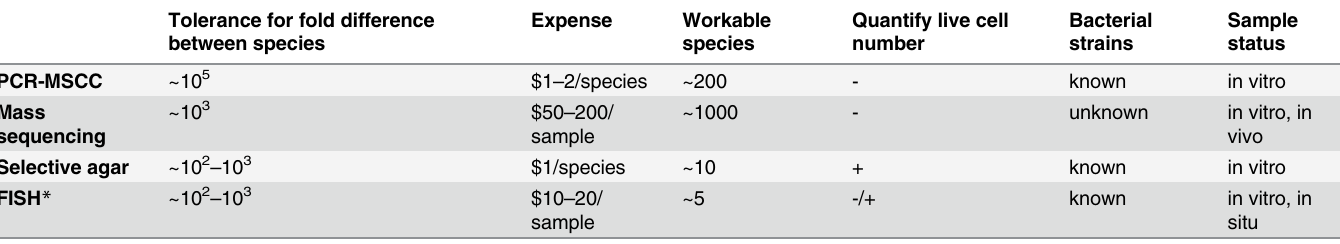
Table 4. Comparison of different cell quantification